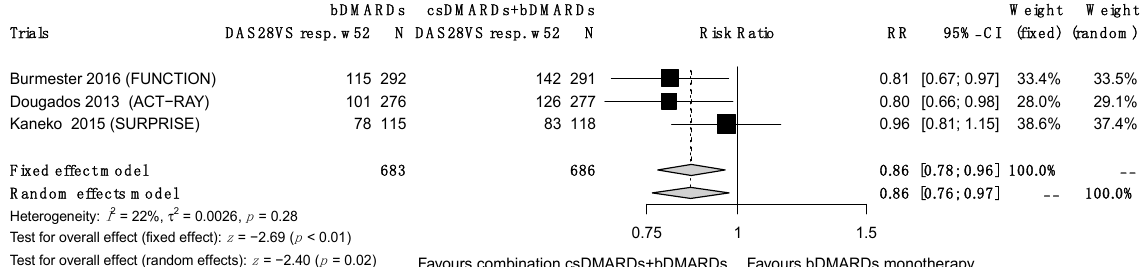
Figure 4. DAS 28–ESR remission at 52 weeks.